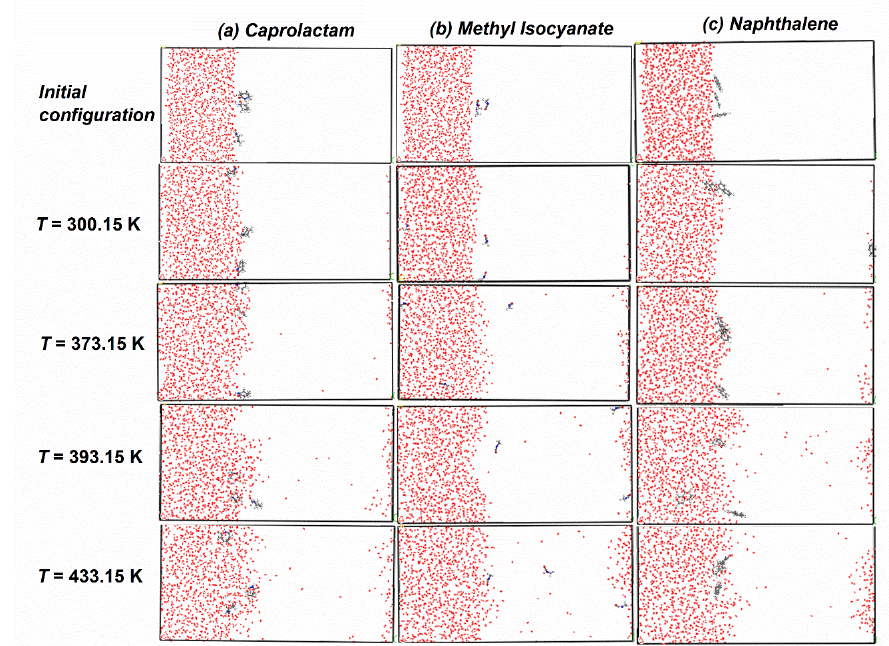
Figure 4. MD simulation depicting the evolution of SVOC dispersion with respect to simulation temperature: a) CAP, b) MIC, c) NAPH. (Red dots represent water molecules and black